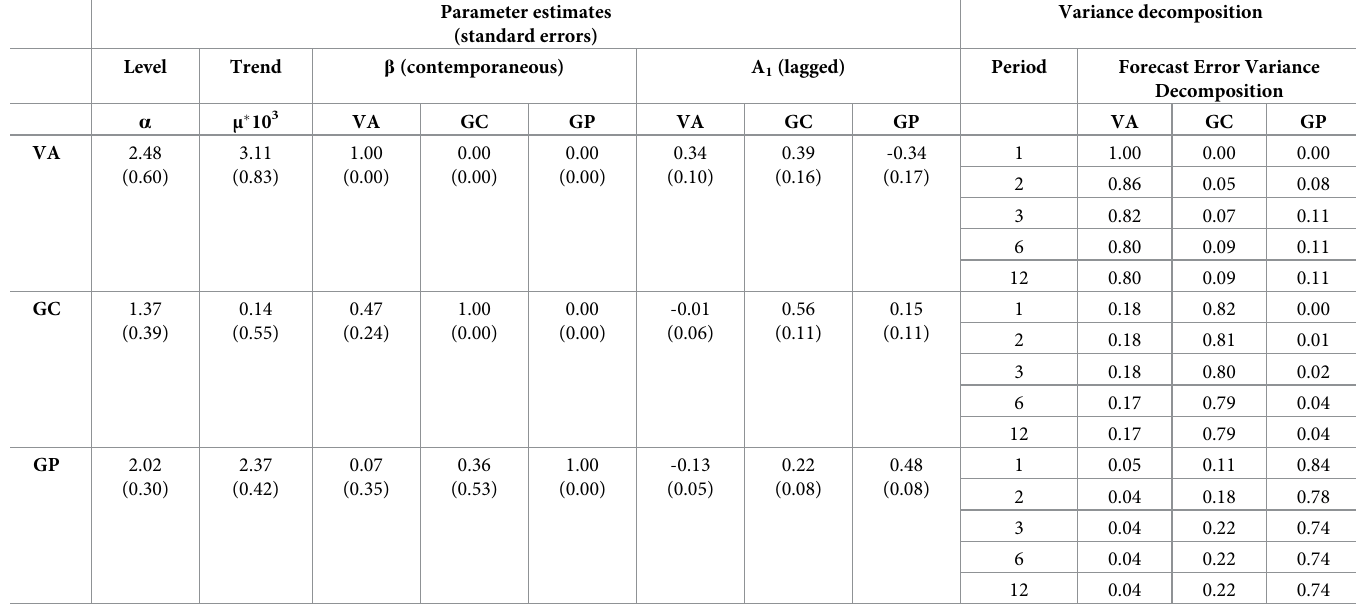
Table 1. Parameter estimates (and corresponding standard errors) and forecast error variance decomposition for the SVAR model (decomposition over 1, 2, 3, 6 and 12 months of shocks in the impulse variable [rows] over the response variables [columns]). Parameter estimates (standard